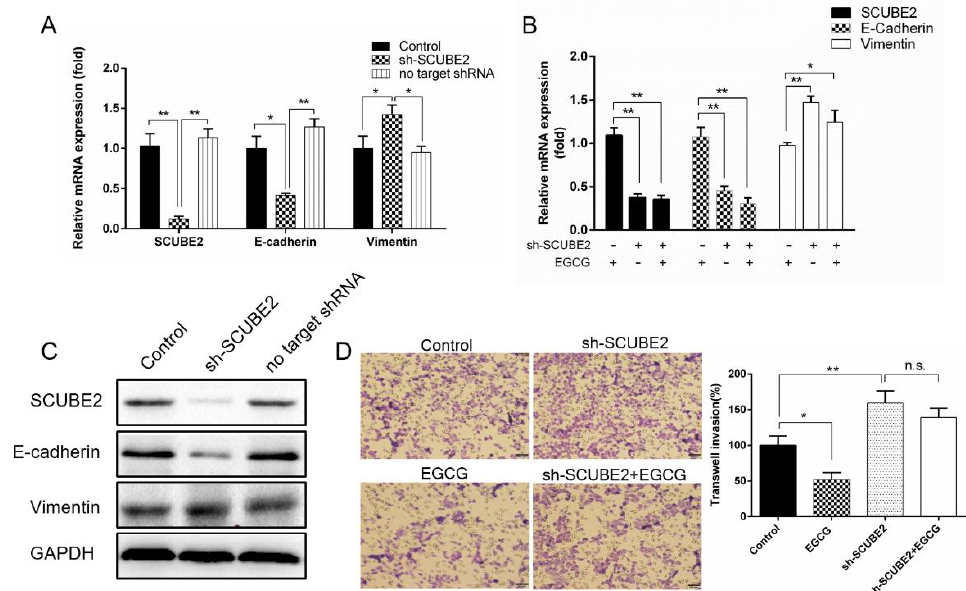
Figure 4. SCUBE2 silencing affected the gene expression and cell invasion in MCF-7 cells. ( A ) The mRNA expressions of SCUBE2 , E-cadherin, and vimentin were detected in the SCUBE2 silencing cells (one-way ANOVA; * p < 0.05, ** p < 0.01 vs. sh- SCUBE2 group). ( B ) The mRNA expressions of SCUBE2 , E-cadherin, and vimentin were detected in the SCUBE2 silencing cells that were treated with EGCG (one-way ANOVA; * p < 0.05, ** p < 0.01 vs. EGCG treatment group). ( C ) The protein levels of SCUBE2 , E-cadherin, and vimentin were detected in the SCUBE2 silencing cells. ( D ) Cell invasion was detected in the SCUBE2 silencing cells that were treated with EGCG (one-way ANOVA; * p < 0.05, ** p < 0.01 vs. control). Scale bars, 50 μm. Data are expressed as mean ± SEM of three independent experiments. n.s. represents no significance.